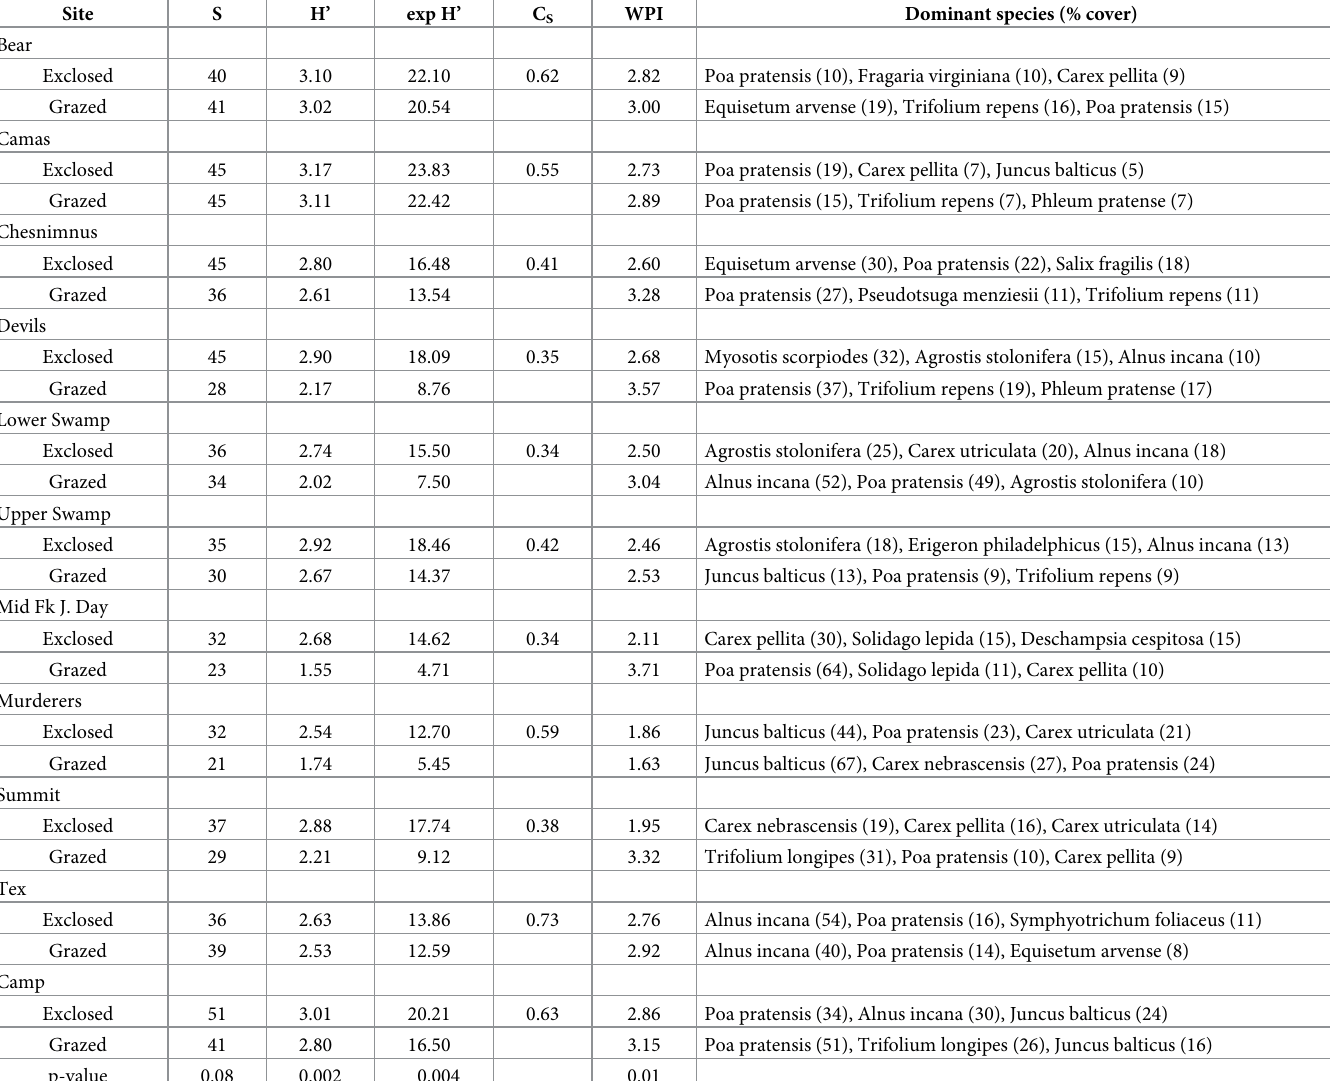
Table 3. Plant species richness (S), species diversity (H’ and exp H’), similarity (C S ), wetland species prevalence indices (WPI), and dominant species and cover (%) for paired exclosed (ungrazed) and grazed stream reaches in northeastern